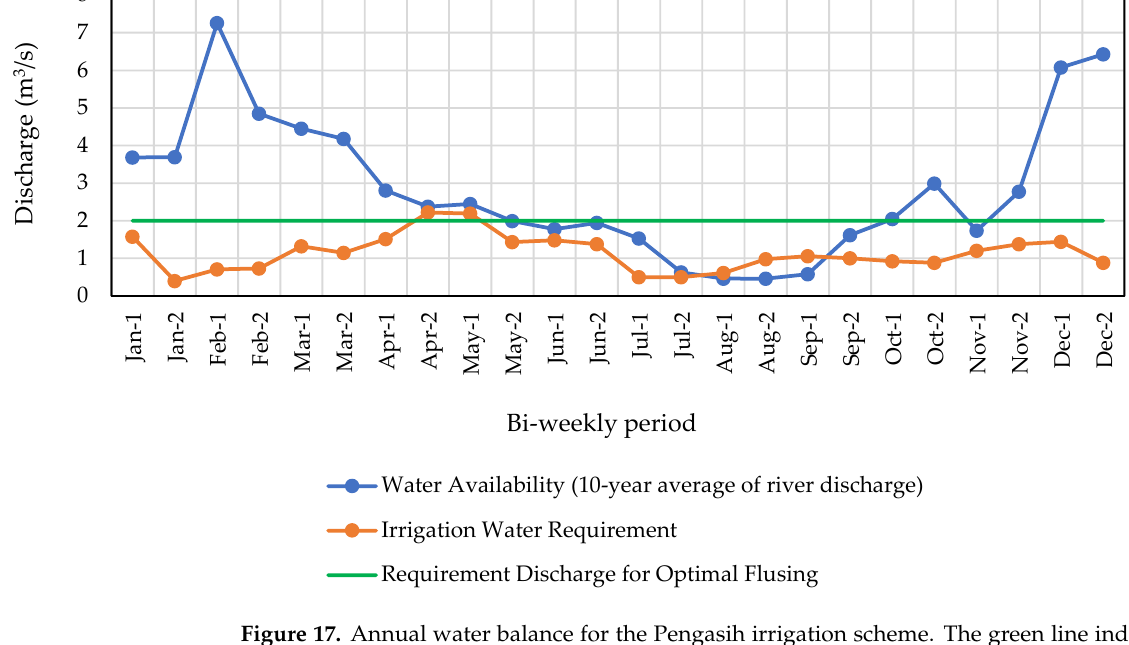
Figure 17. Annual water balance for the Pengasih irrigation scheme. The green line indicates the required discharge for the optimal flushing of the sand trap, while the blue and orange line denote the water availability and irrigation water requirements, respectively.